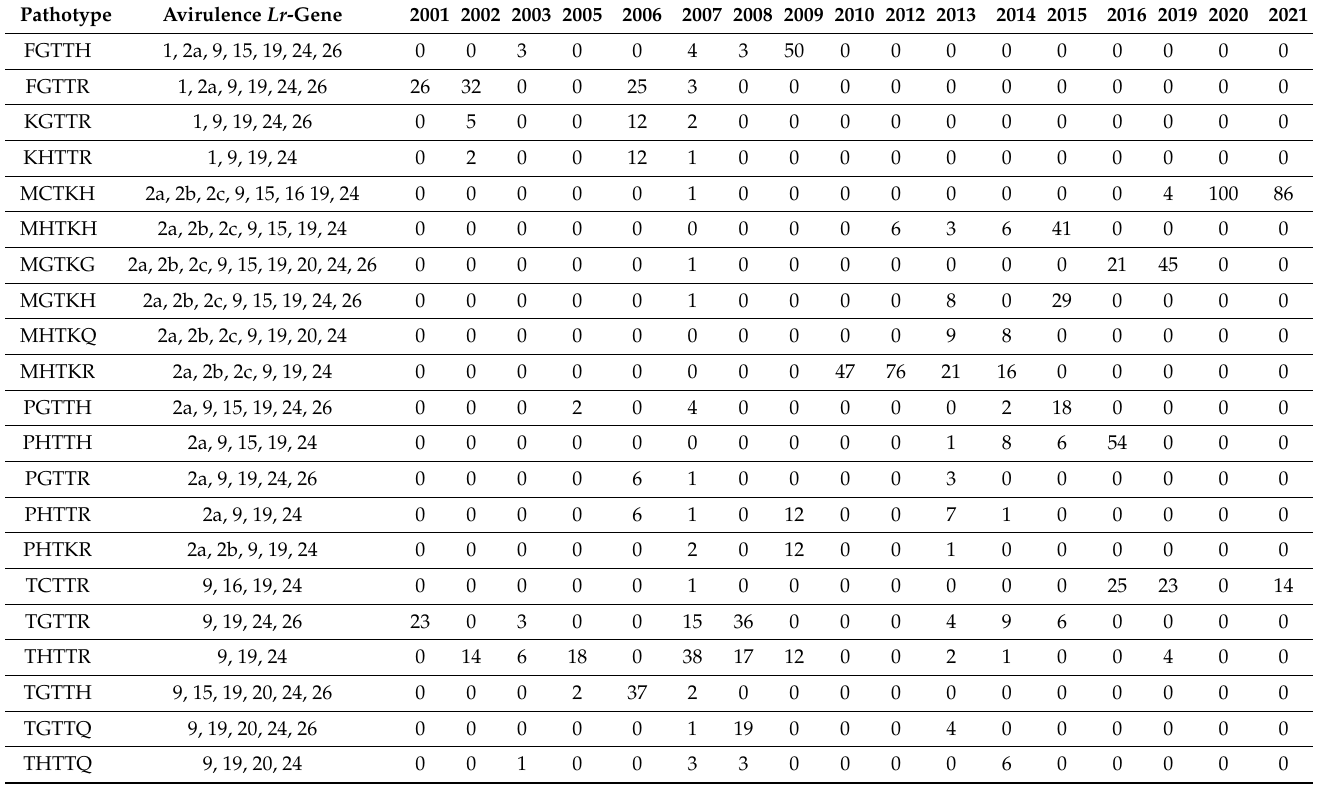
Table 4. The predominant pathotypes of Puccinia triticina and their frequencies in North-Western Region of Russia in